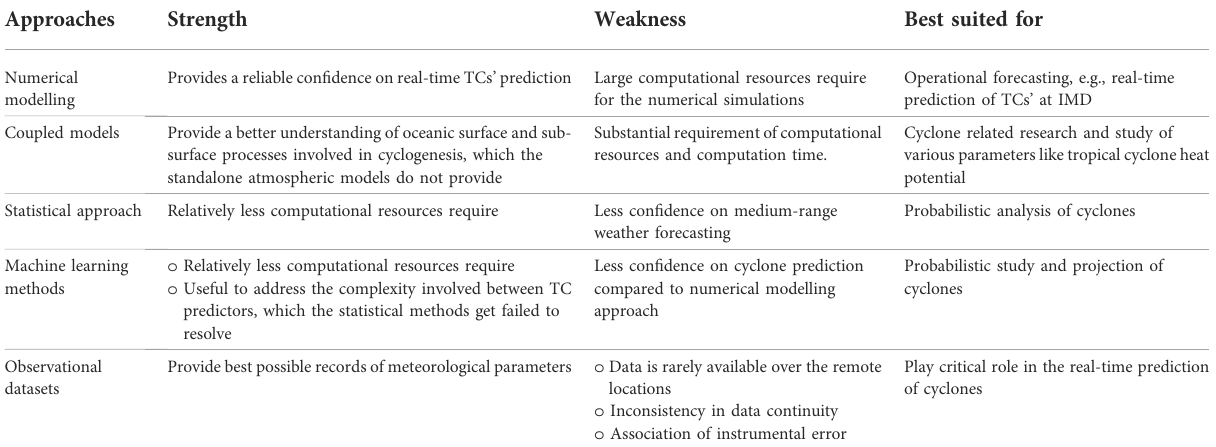
TABLE 3 Advantages and disadvantages of different methods over one